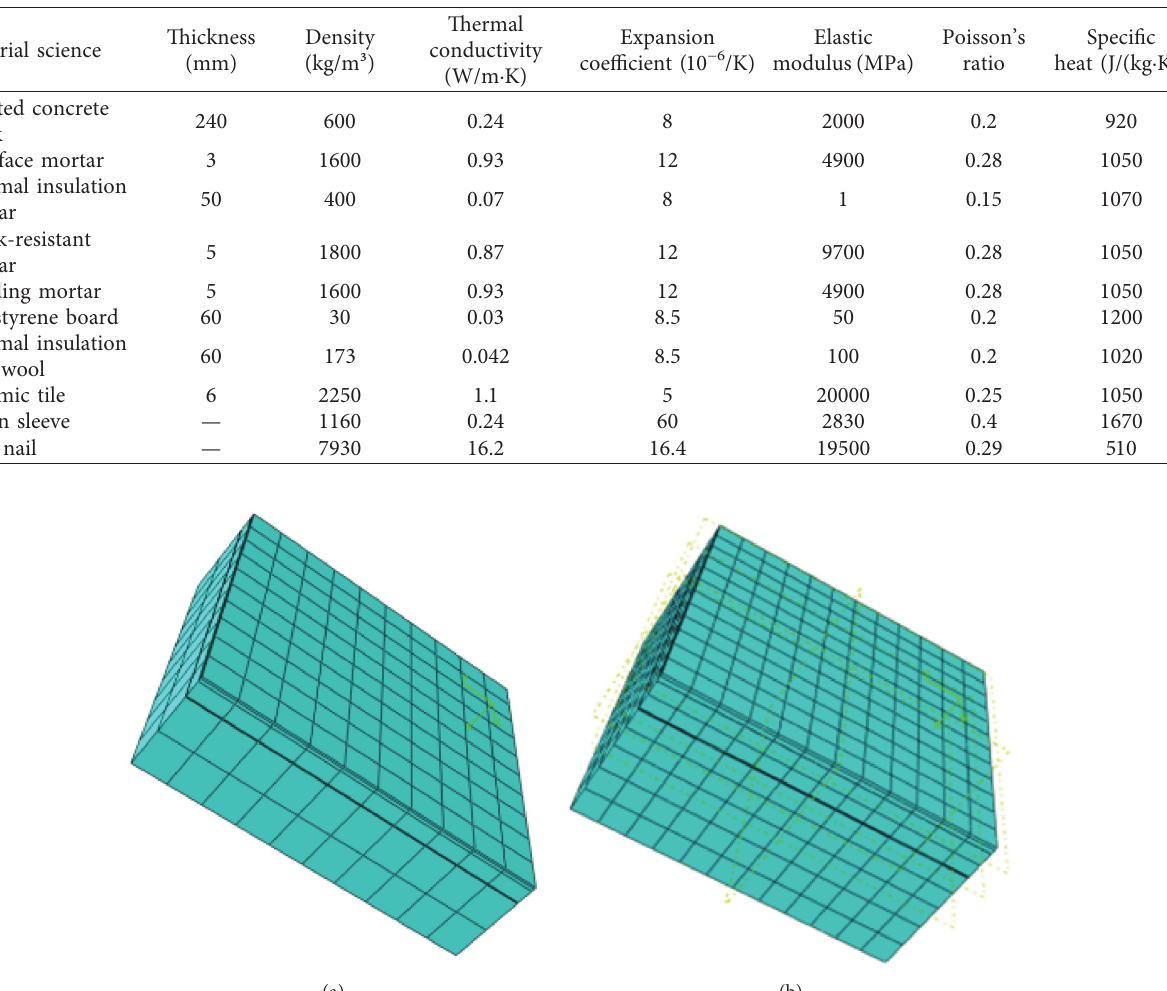
Figure 14: Finish layer structure diagram (1, masonry wall; 2, interface layer; 3, insulation layer; 4, adhesive layer; 5, face brick; 6, anchor bolt). (a) Rigid finish layer. (b) Semirigid and flexible finish layer. Table 5: Material parameter table.